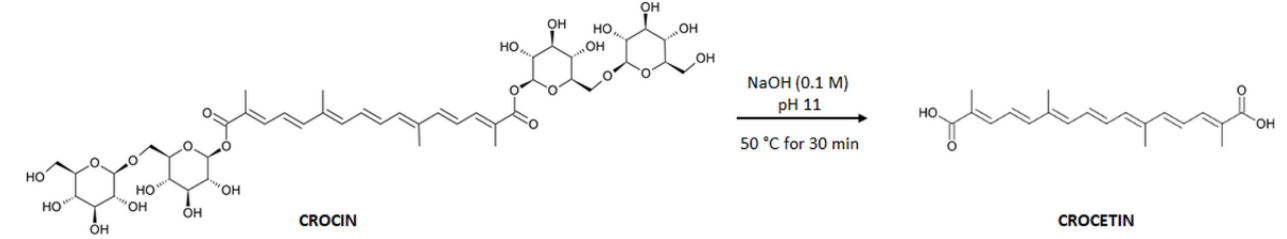
Figure 1. Chemical conversion of crocin to crocetin.